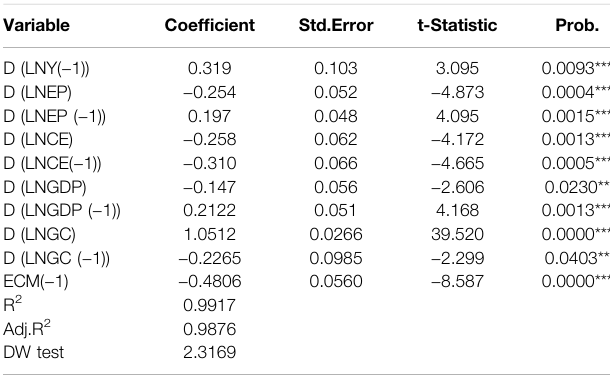
TABLE 6 | ARDL-ECM short-run estimates.